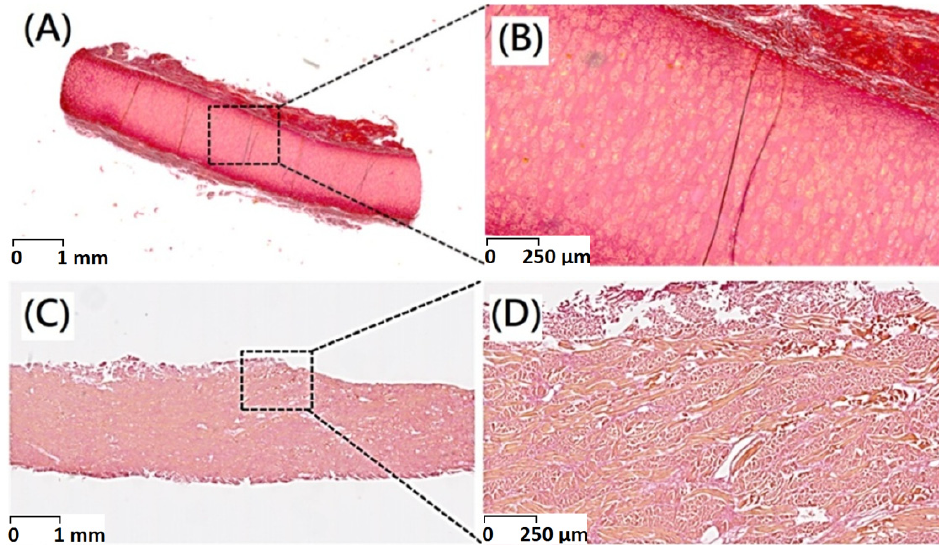
Figure 4. Picro-Sirius red stain of ( A ) original porcine dermal (scale bar indicates 1 mm), ( B ) original porcine dermal (scale bar indicates 250 µ m), ( C ) porcine dermal segments after decellularization (scale bar indicates 1 mm), and ( D ) porcine dermal segments after decellularization (scale bar indicates 250 μ m).